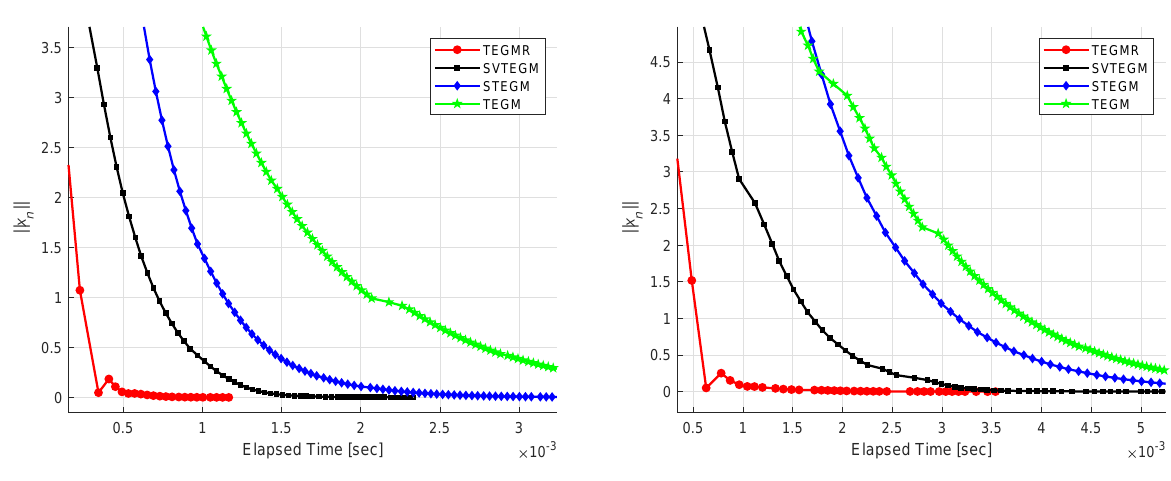
Figure 5. Example 5, ( left ): m = 5 and ( right ): m = 10.